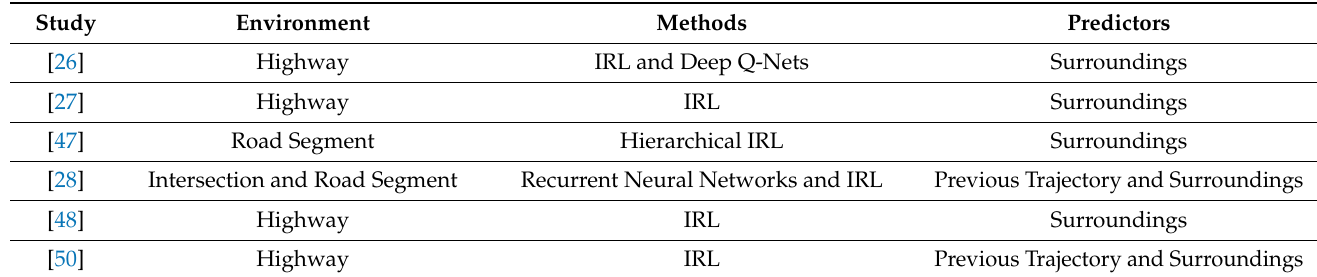
Table 1. An Overview of Studies on Trajectory Prediction using IRL.